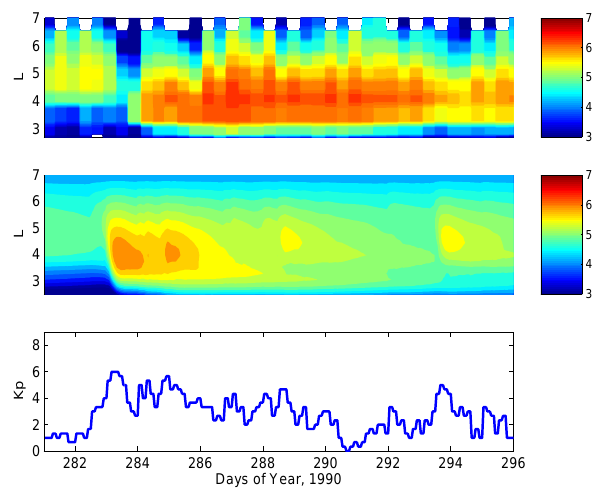
Fig. 3. Comparison of electron fluxes in log 10 (cm 2 srsMeV) mea- sured by CRRESS at 0.95MeV (top), and our radial diffusion model simulations with empirical lifetimes (middle). Evolution of the K p index